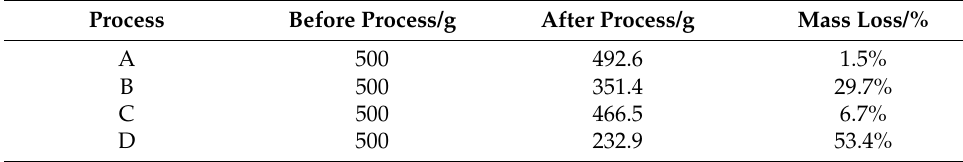
Table 2. Quality change of raw materials before and after heat